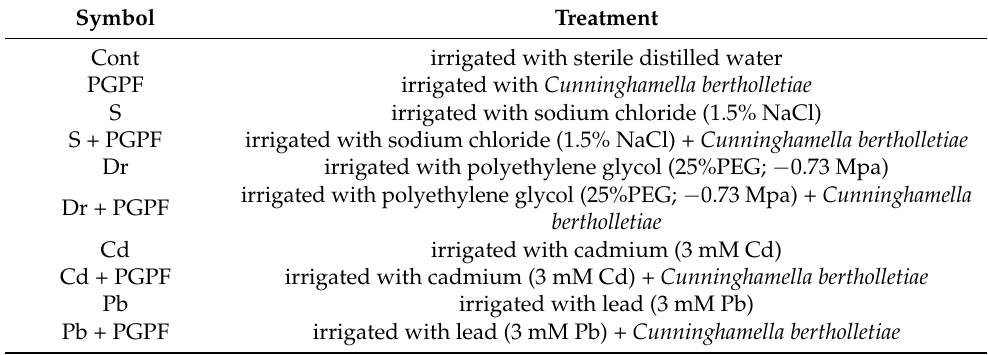
Table 3. Experimental work